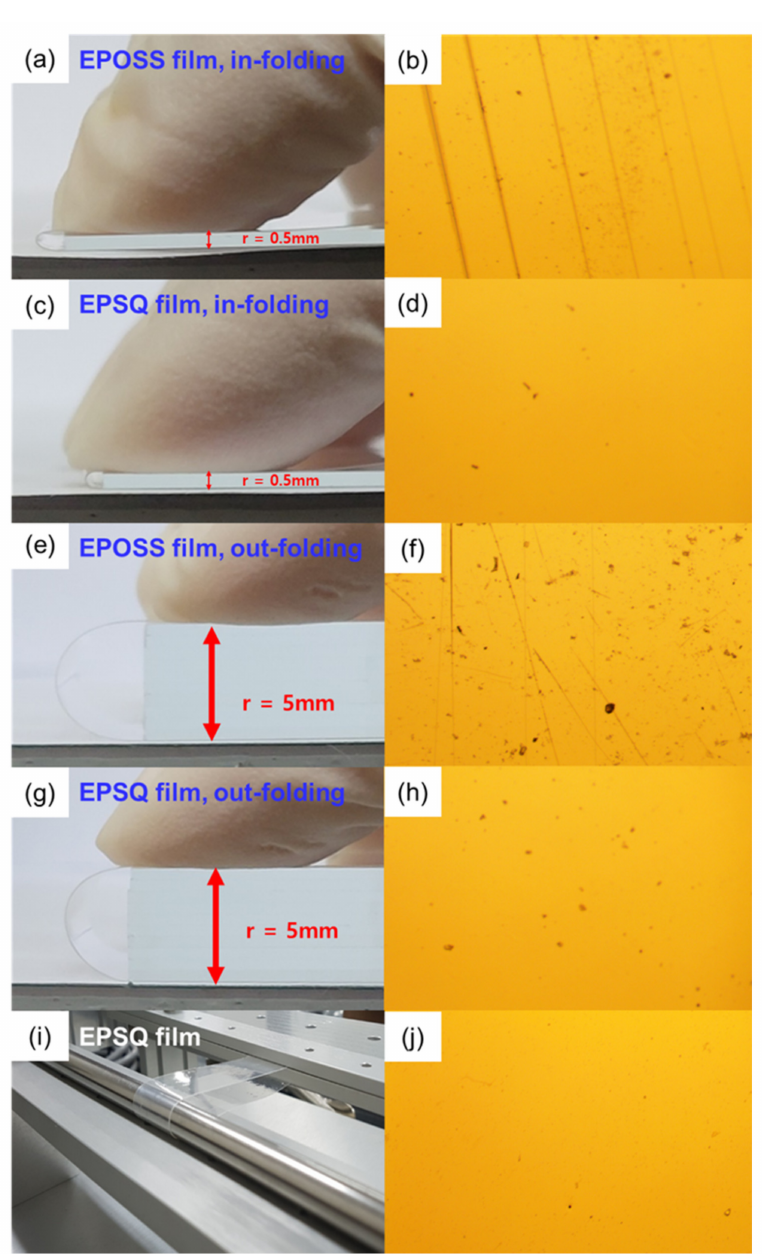
Figure 6. Folding test of EPOSS and EPSQ films. ( a ) In-folding test (r = 0.5 mm) and ( b ) microscope image of EPOSS film, ( c ) in-folding test (r = 0.5 mm) and ( d ) microscope image of EPSQ film, ( e ) out- folding test (r = 5 mm) and ( f ) microscope image of EPOSS film, ( g ) out-folding test (r = 5 mm) and ( h ) microscope image of EPSQ film, ( i ) 100,000 cycles of in-folding cycles test (r = 1.5 mm) and ( j ) microscope image of EPOSS